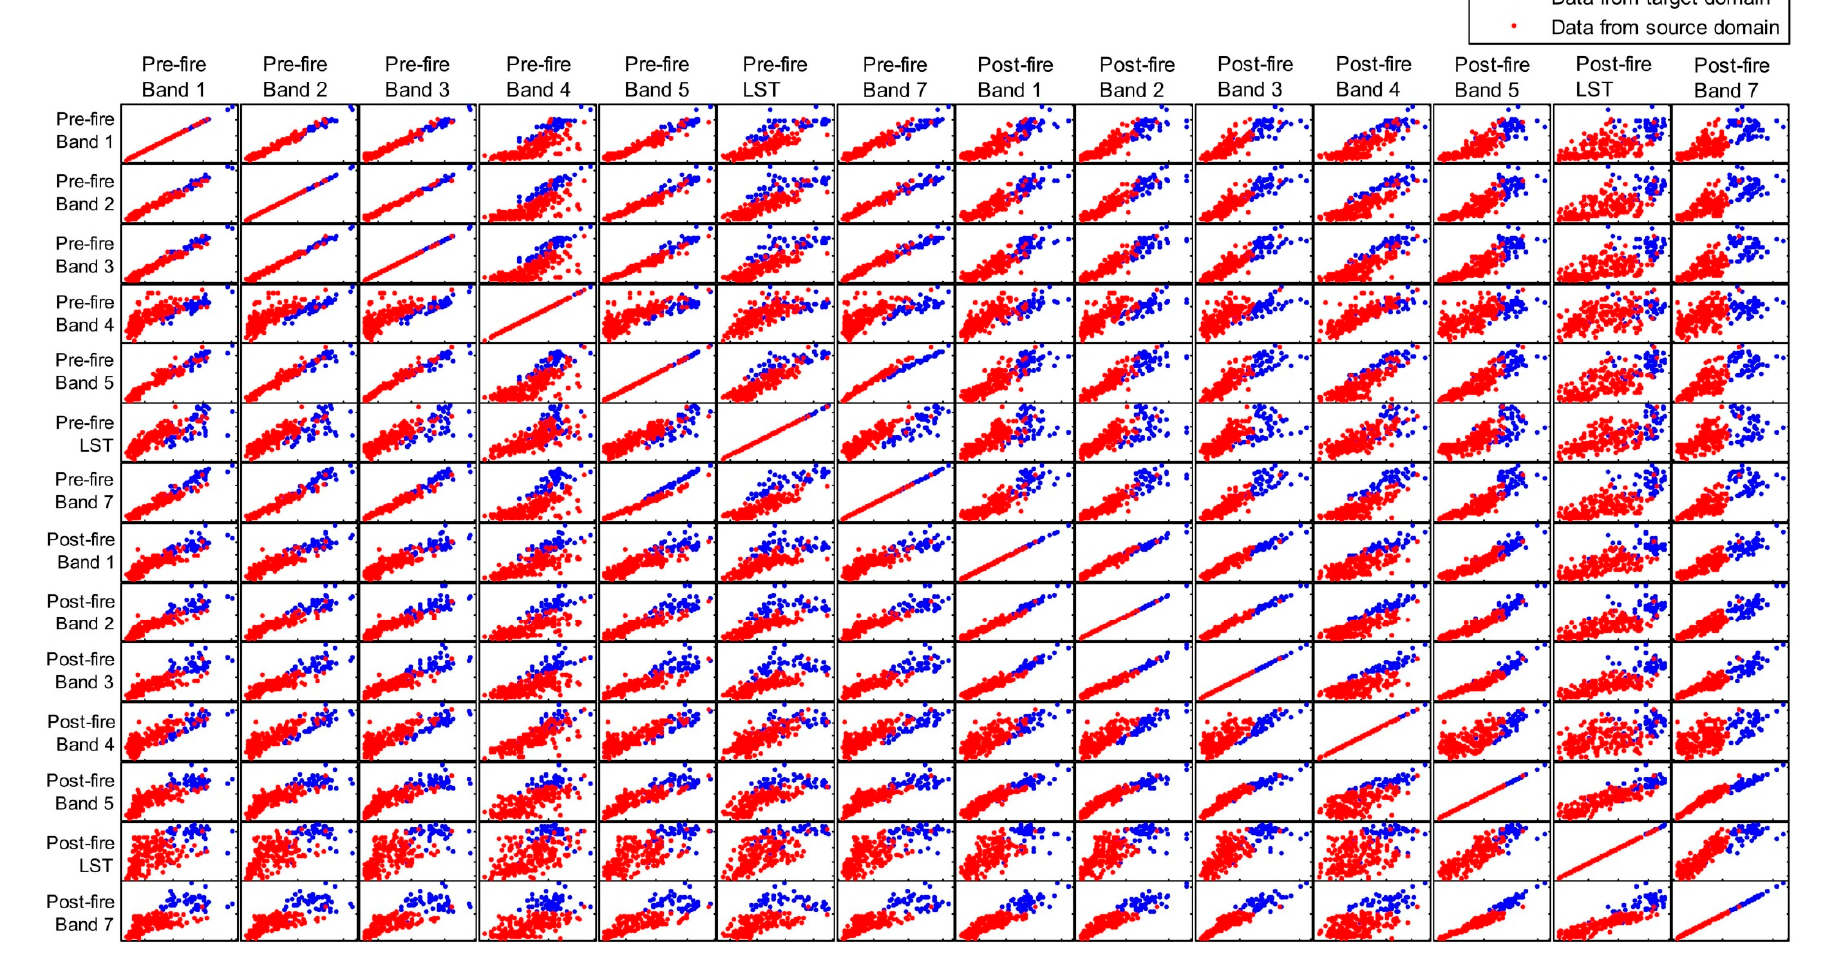
Figure 4. The scatter plot matrix of original spectral feature space over Bear Fire. Each panel is one scatter plot of a pair of spectral bands. Blue dots are field survey data from the target domain area: Bear Fire (n = 55). Red dots are field survey data from source domain areas: Jasper, Mule, and PW03-Wolf Fires (n = 199). Note that the distributions of data from target domain area and source domain areas are different in original spectral feature spaces.